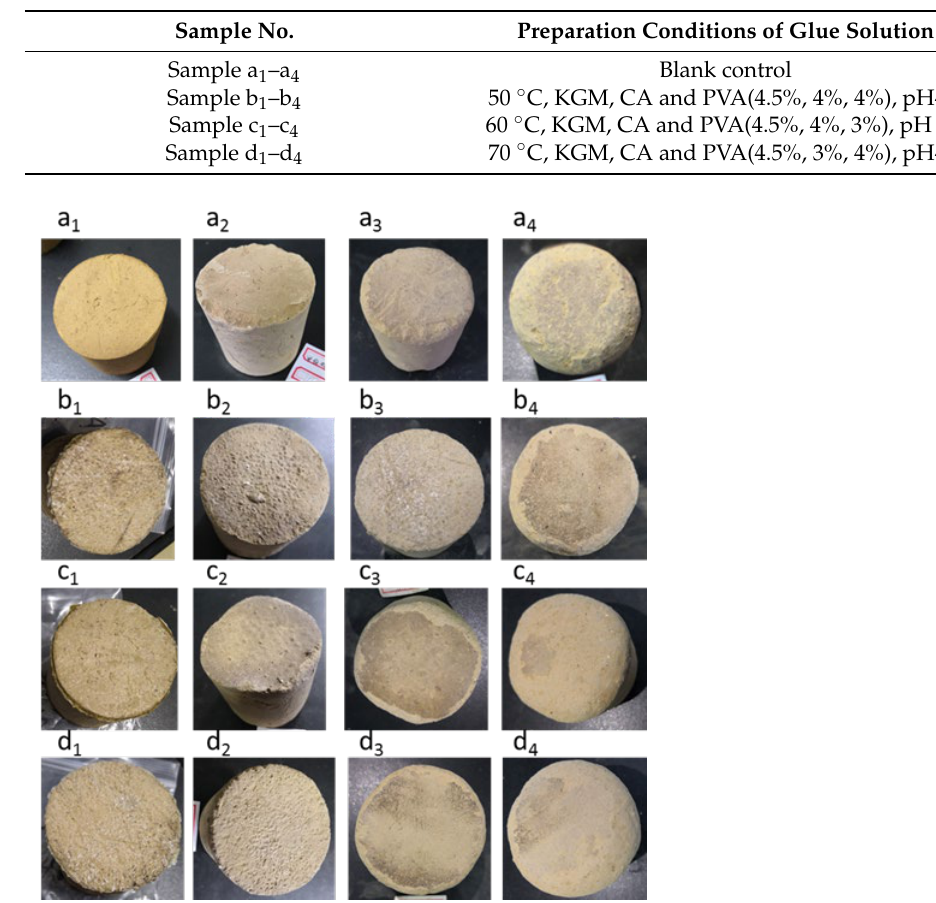
Table 2. Details of Consolidated Soil Column Samples.